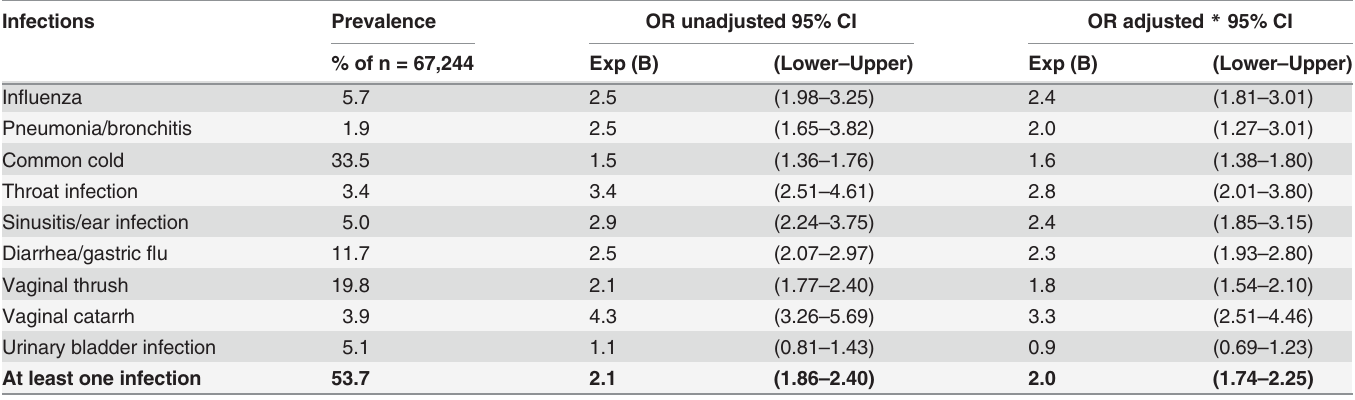
Table 1. Associations between relationship satisfaction a and self-reported infectious